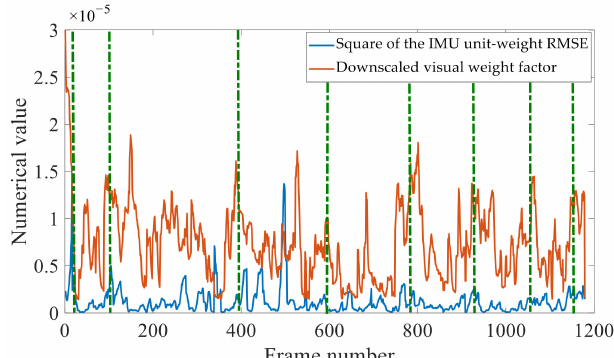
Figure 8. Real-time relationship between visual weight factor adjustments and IMU precision.